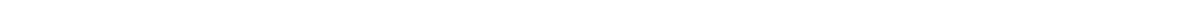
Fig. 9. Dorsal valves of rafinesquinine brachiopod Kjaerina ( Villasina ) pedronaensis sp. nov.; Katian, Upper Ordovician; Portixeddu Formation at Punta Pedrona (A, B, D–H) and Gonnesa (I), Sardinia, Italy; Gabian Formation, Montagne Noire, France (C). A . MPZ 2015/1363, holotype, internal mould (A 1 ), latex cast of dorsal interior (A 2 ), detail of cardinalia in anteroblique view (A 3 ). B . MPZ 2015/1364, paratype, internal mould (B 1 ) and latex cast of dorsal interior (B 2 ). C . MPZ 2015/1370, latex cast of interior of an incomplete valve. D . MPZ 2015/1365, paratype, detail of multicostellate radial ornament dorsal exterior (D 1 ) and latex cast of exterior (D 2 ) of a specimen with conjoined valves. E . MPZ 2015/1366, paratype, internal mould (E 1 ) and latex cast of dorsal interior (E 2 ). F . MPZ 2015/1367, paratype, latex cast of dorsal interior (F 1 ) and detail of cardinalia in anteroblique view (F 2 ), showing the posteroventrally engrossed cardinal process lobes of the specimen. G . MPZ 2015/1368, paratype, latex cast of exterior of a specimen with conjoined valves in dorsal (G 1 ) and posteroblique (G 2 ) views, showing the ventral interarea, chilidium, and hinge line. H . MPZ 2015/1369, paratype, latex cast of exterior of a specimen with conjoined valves in dorsal (H 1 ) and posteroblique (H 2 ) views, showing the ventral interarea, chilidium, and hinge line. I . MPZ 2015/1371, latex cast if interior. Scale bars 2